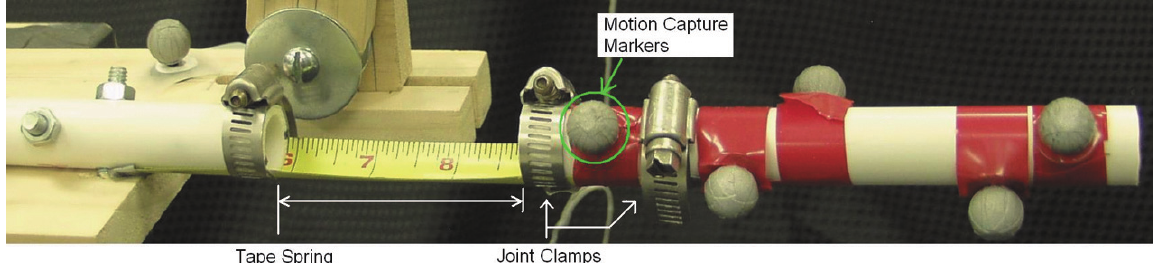
Fig. 2. The tape spring hinge was constructed by attaching a length of measuring tape between two tubes with clamps. Markers for the videogram- metry system are also attached to the free end. of the large-scale motion is needed in order to predict 3-D position during deployment, and therefore predict binding and buckling of complicated